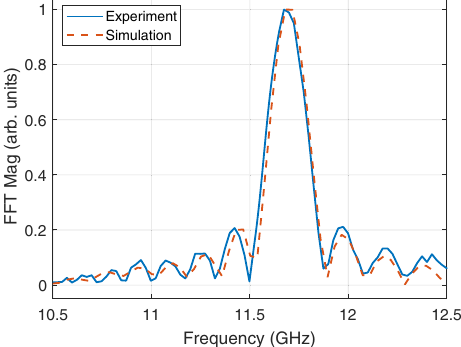
FIG. 18. FFTof the rf pulse in Fig. 17 from a single 7 nC bunch and accompanying PIC simulation results.